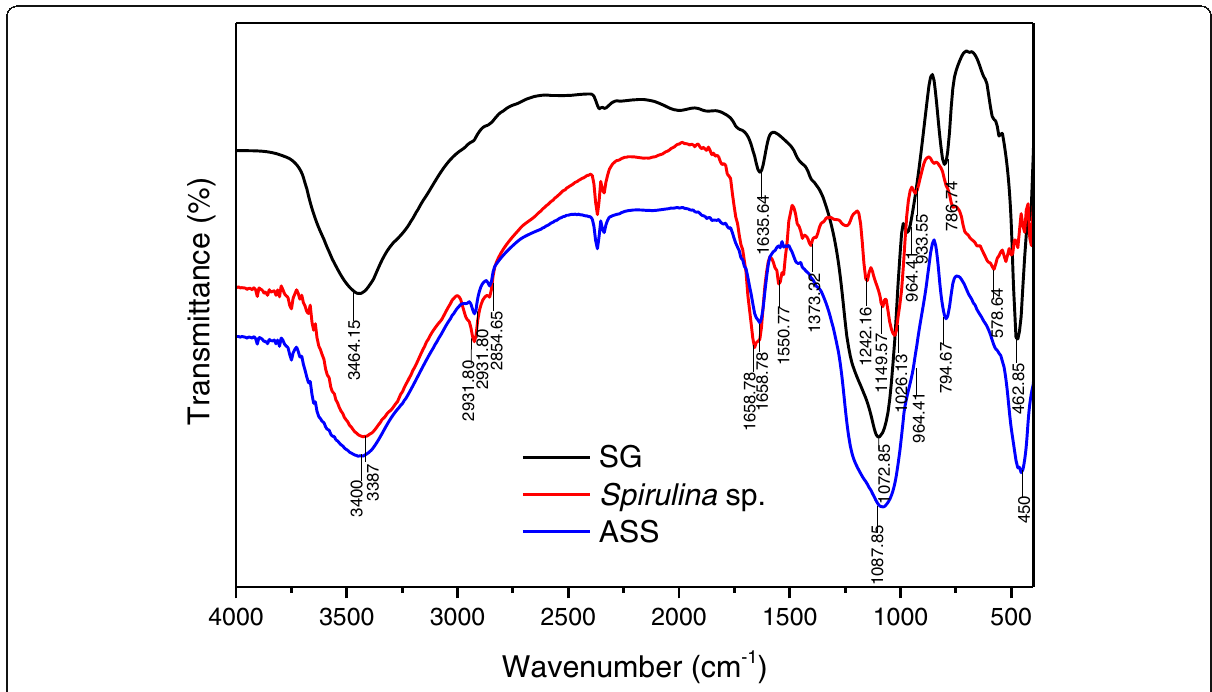
Fig. 1 FTIR spectra of SG, Spirulina sp. algae biomass and ASS